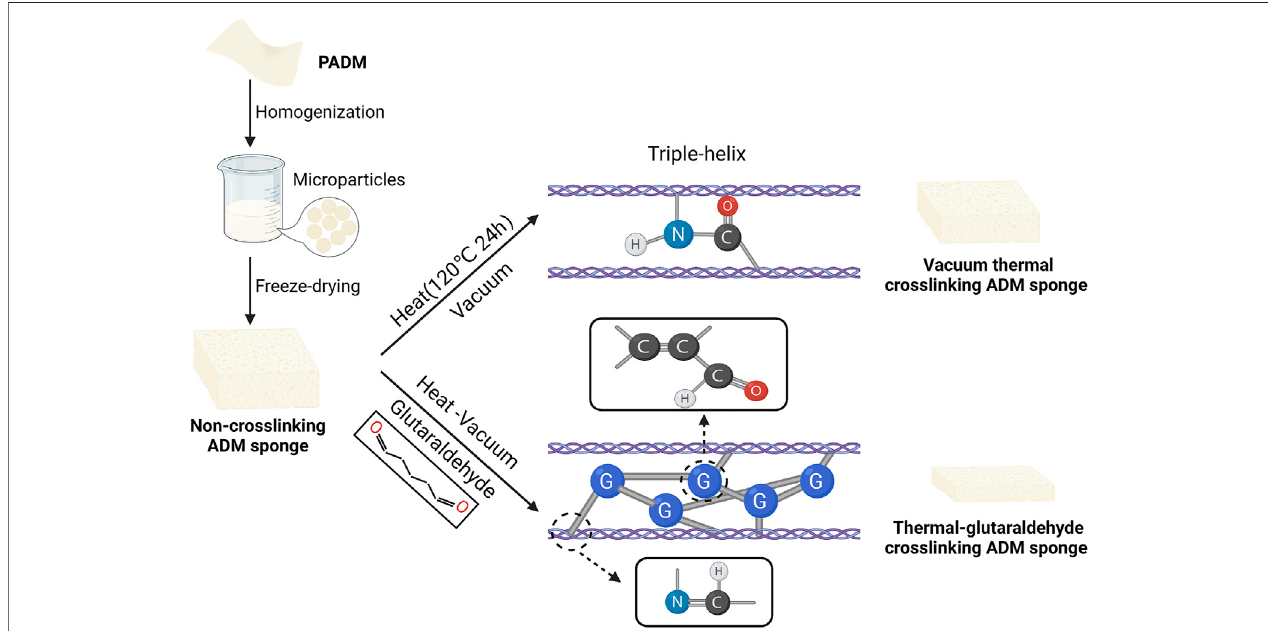
FIGURE 1 | Process scheme of crosslinked ADM sponge